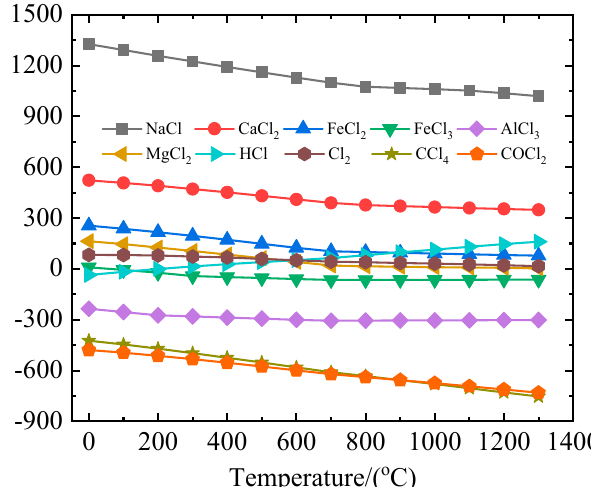
Figure 2. The standard Gibbs free energies of reactions between V 2 O 5 and chlorination agents (reactions 11–20).